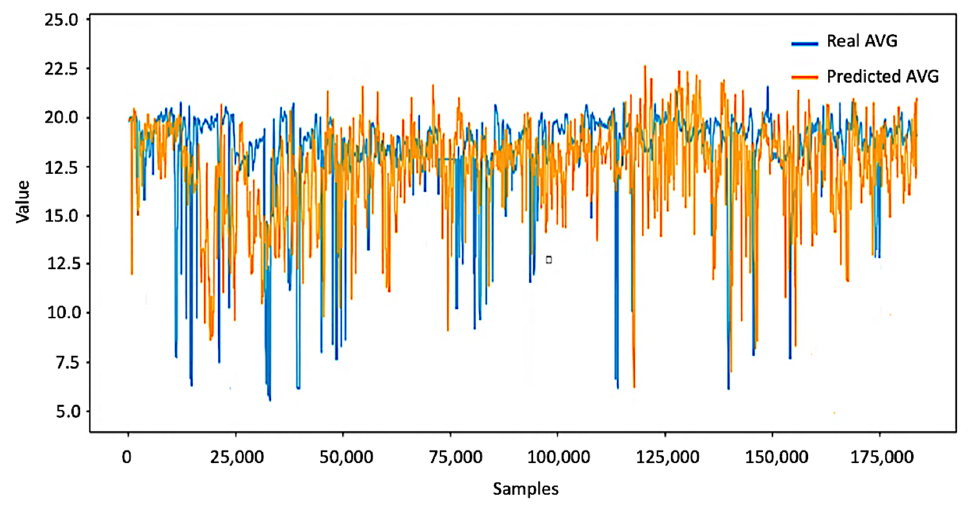
Figure 4. Real and 90-day forecast values (after smoothing) for pressure.